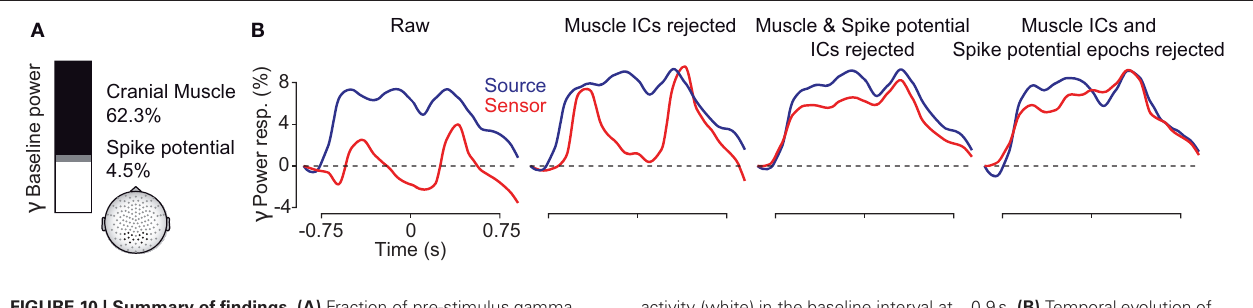
FIGURE 10 | Summary of findings. (A) Fraction of pre-stimulus gamma power at EEG sensors above the visual cortex related to extracranial muscle activity (black), saccadic spike potentials (SP, gray), and putative neuronal